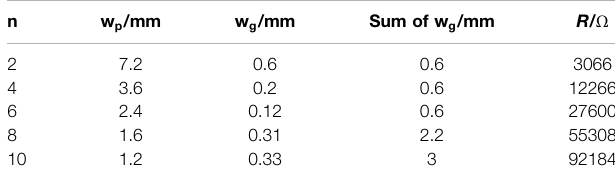
TABLE 3 | Design parameters and resistance for different n